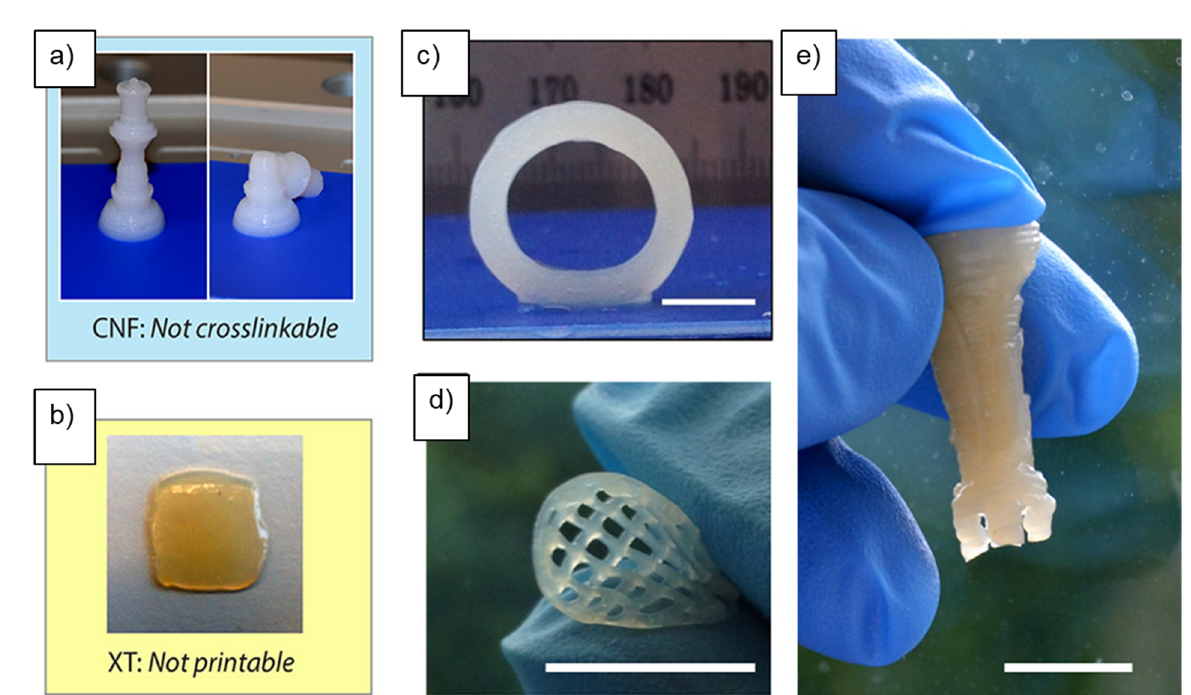
Figure 3. A queen chess piece printed with pure CNFs which collapsed due to lack of crosslinking ( a ), poor printability shown by unsuccessful grid printed with pure XT ( b ). Three-dimensional printed and crosslinked, freestanding and crosslinked cylinder ( c ) grid, handled and bent in air ( d ). Rook chess piece, held upside down from optimized formulation of CNF and XT ( e ), reprinted with permission from ref. [49]. Copyright 2017, American Chemical Society.